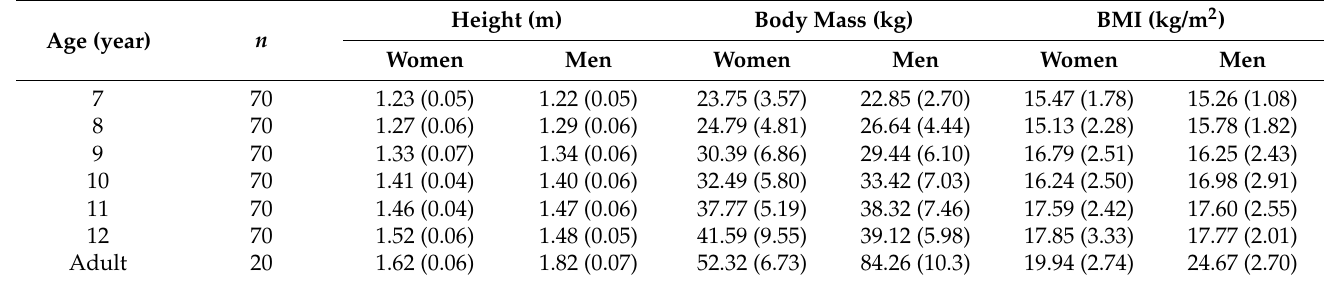
Table 1. Demographic characteristics of the participants.